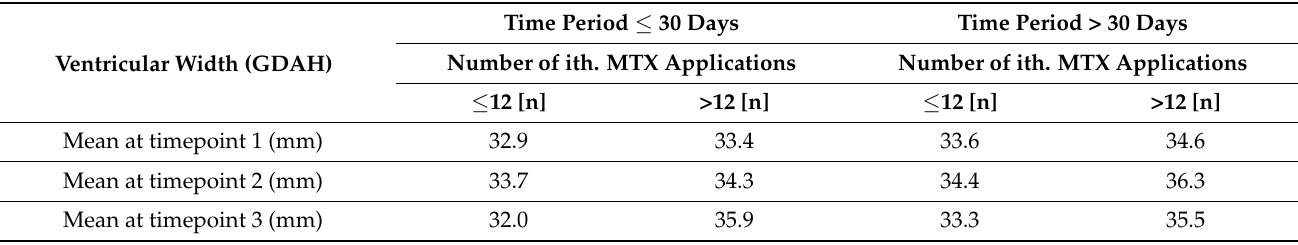
Table 3. Ventricular width (GDAH) at different timepoints (t1, t2 and t3) and their differences depending on the number of ith. MTX applications. Highlighted numbers are significantly different ( p <